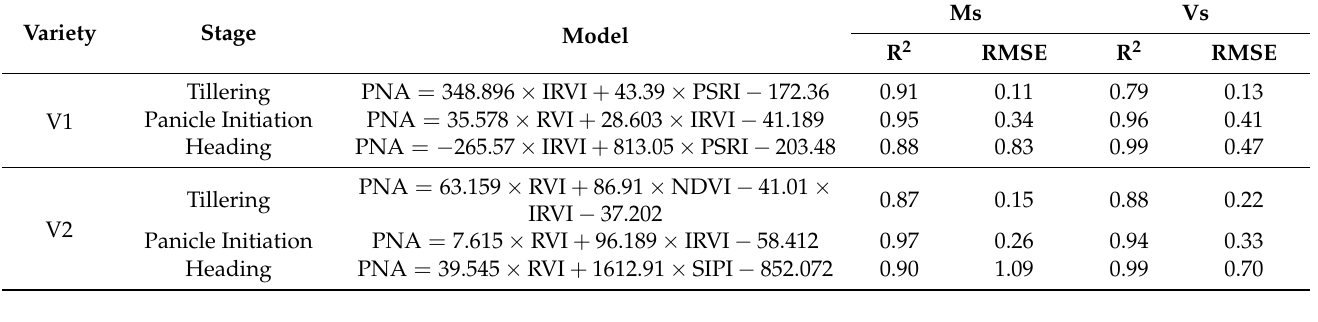
Table 6. Plant nitrogen accumulation (PNA) regression models and their accuracy for different rice varieties ( n = 15).